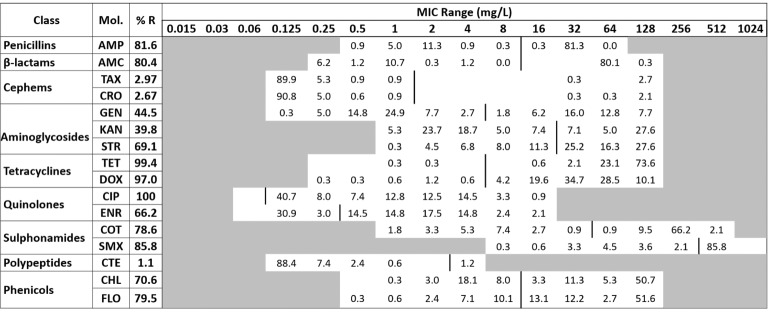
The distribution of the various minimum inhibitory concentration (MIC) levels of the Salmonella against 16 antibiotics. The names of the antibiotics (second column) are abbreviated as ampicillin (AMP), amoxicillin (AMC), cefotaxime (TAX), ceftriaxone (CRO), gentamicin (GEN), kanamycin (KAN), streptomycin (STR), tetracycline (TET), doxycycline (DOX), ciprofloxacin (CIP), enrofloxacin (ENR), sulfa-trimethoprim (COT), sulfamethoxazole (SMX), colistin (CTE), chloramphenicol (CHL), and florfenicol (FLO). The third column shows the average resistance (in percentage); the second row is the range of the MIC tested; and the values in each cell show the percentage of strains in that particular MIC dilution level. The vertical bar indicates the cutoff level of the minimum inhibitory concentration for each antibiotic at the highest value of that particular cell’s dilution for susceptibility (equal to or less than) and resistance (greater than). For the sake of clarity and facilitate analysis, the intermediate category was merged with the resistant.